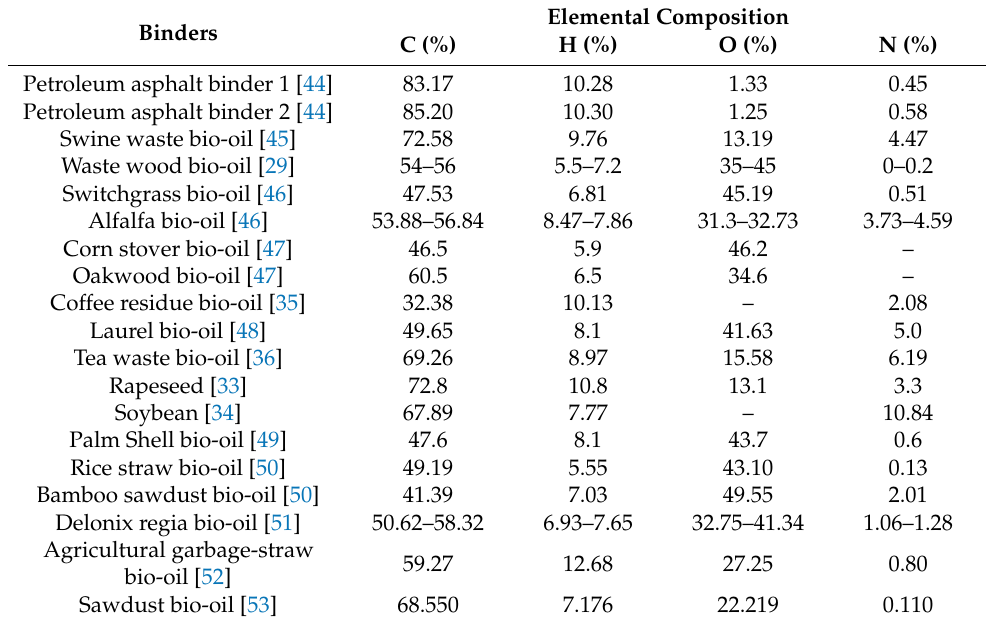
Table 2. Elemental composition of